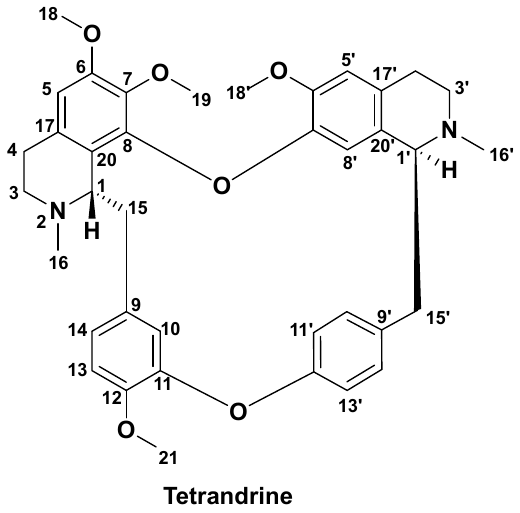
Figure 1. The structure of tetrandrine.